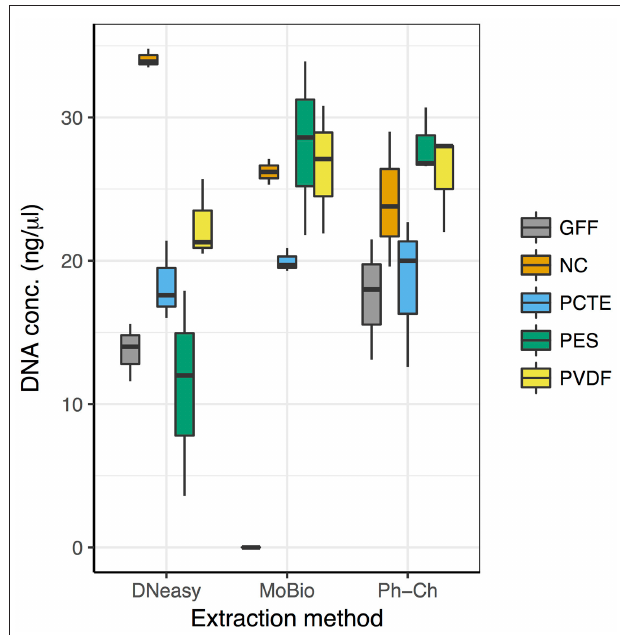
FIGURE 2 | Distributions of DNA concentrations (ng/ µ l) in extractions obtained using the 15 different combinations of filter types and extraction methods. n = 3 for each